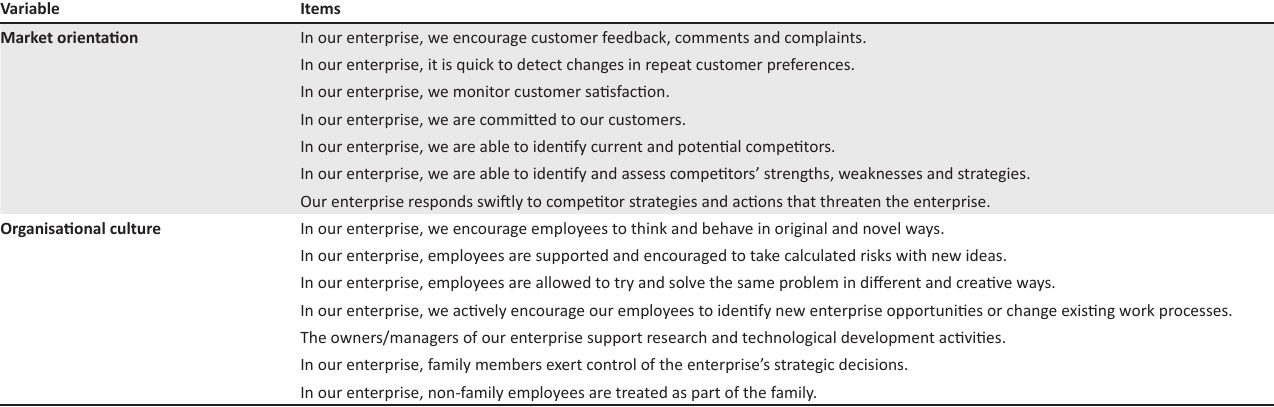
TABLE 1-A1 (continues...): Items used in the questionnaire. Variable Items Market